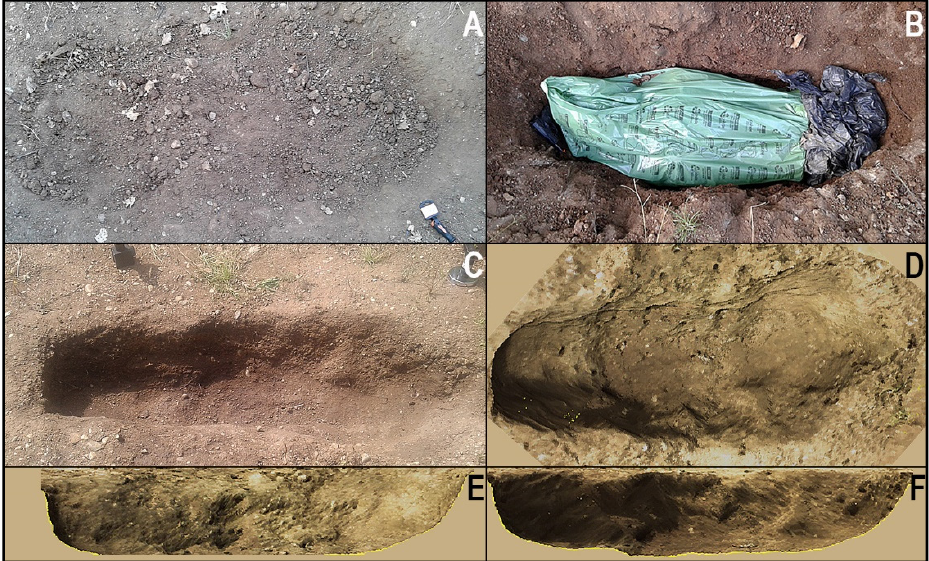
Figure 4. The appearance of simulated clandestine graves dug with a spade and shovel in the experimental field at the scientific campus of Messina University. ( A ) Plan view of a simulated shallow grave with an ellipsoidal shape and “foot-like” appearance closed after posing a bust of a plastic mannequin closed in two plastic garbage bags at the bottom. The pit was 50 cm deep and 1 m long. ( B ) Pit hosting the bust closed in two plastic garbage bags before the filling with sediments. ( C ) Plan view of a shallow grave with an elongated shape and “bathtub” appearance (for hosting the lower limb of a plastic mannequin) before the filling with sediments. The pit was 20 cm deep and 1 m long. ( D ) Plan view of the 3D reconstruction by laser scanning of the pit. ( E ) East lateral view of the 3D reconstruction by laser scanning of the pit. ( F ) West lateral view of the 3D reconstruction by laser scanning of the pit.